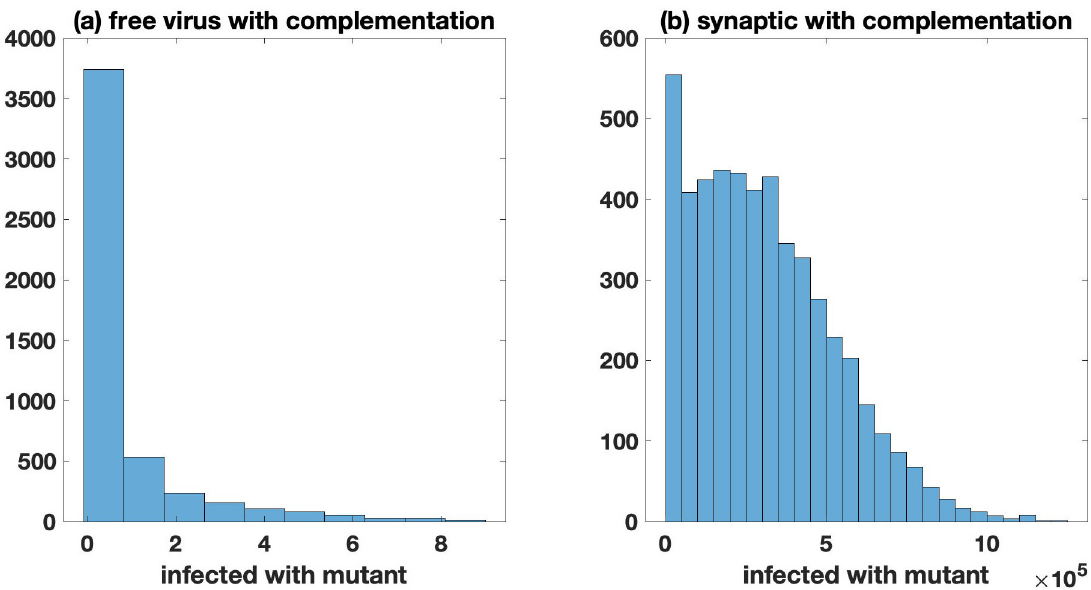
Fig 3. Zero fitness mutants, comparing the effect of complementation for free virus and synaptic transmission. All simulations start with a single infected cell coinfected with a single copy of both the wild-type and mutant, and mutation is turned off ( μ = 0). A Only free virus transmission ( β = 3.60 × 10 − 9 , γ = 0, N = 11) with complementation. The average number (standard deviation) of cells infected with the mutant is 0.71 (1.73). B Only synaptic transmission ( β = 0, γ = 3.60 × 10 − 9 , N = 25, see Section 1.3 of S1 Text for justification) with complementation. The average number (standard deviation) of cells infected with the mutant is 3.1 × 10 5 (2.2 × 10 5 ). Histograms represent 5 × 10 3 hybrid simulations with size threshold M ¼ 50 . Simulations in which infections are not established (or in the rare case a simulation does not reach the infected size threshold) are discarded; simulations are stopped when the infected cell population is close to peak infection (5 × 10 8 cells). The fitness of the wild-type is fixed at F wild-type = 0.9 and F mutant = 0. The other parameters are as in Fig 1 ( λ = 1.59 × 10 7 , a = 0.45, and d =